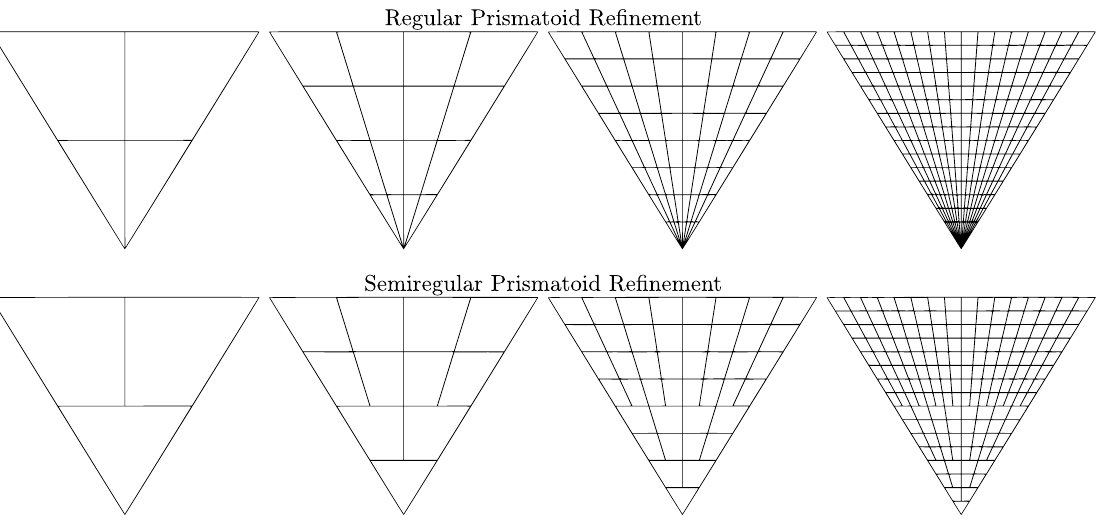
Figure 6. Three levels of successive applications of regular (top) and semiregular (bottom) prismatoid refinement. Only the side of a single pyramid starting cell is shown to highlight the behaviour of the two schemes at different radii. Note how cells degenerate towards the centre with regular refinement, whereas this issue is not present in the semiregular